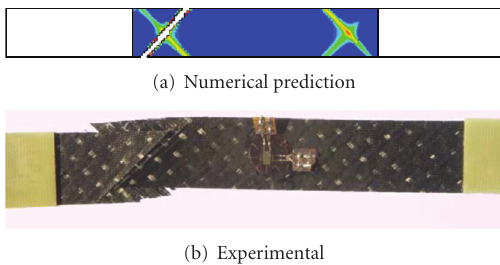
Figure 26: Comparison between predicted and experimental failure locations for the in-plane shear